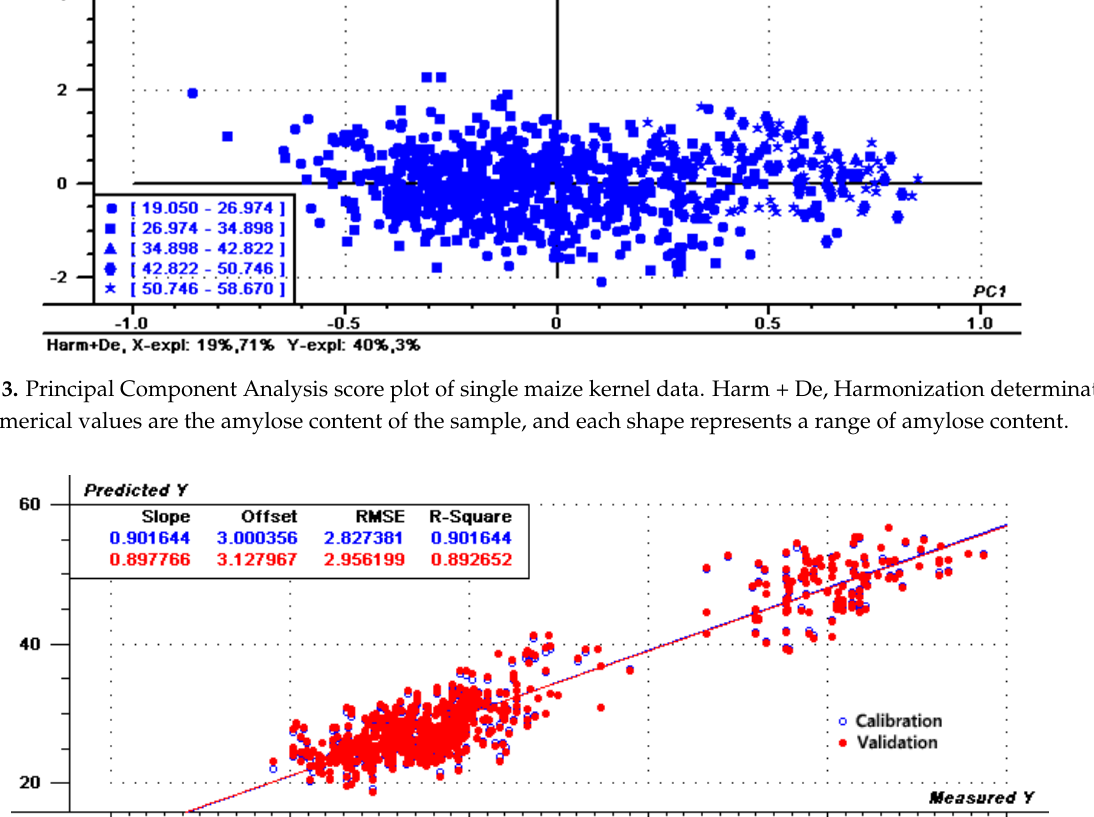
Agronomy 2021 , 11 , x FOR PEER REVIEW